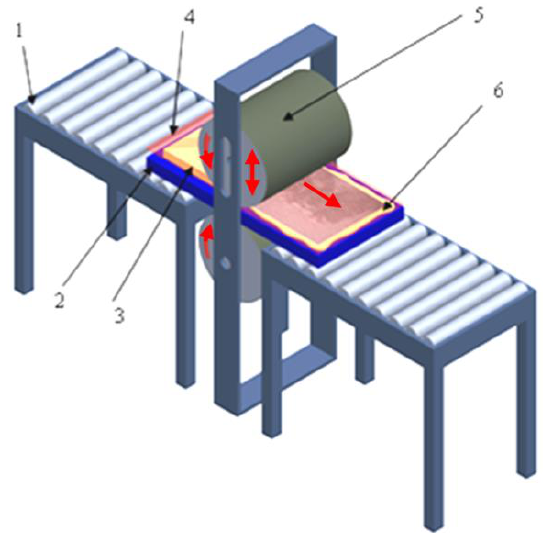
Figure 2. The scheme of GFRP pressing device: 1 — worktable, 2 — mold, 3 — composite layers, 4 — foil, 5 — pressing cylinder device, 6 — resin excess.